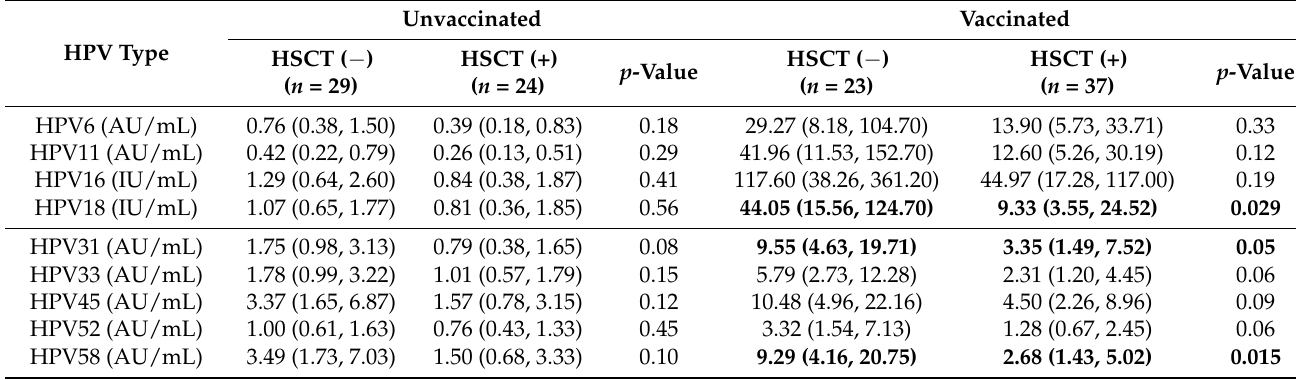
Table 7. HPV Serotiters by HPV Vaccine and History of HSCT in Participants with